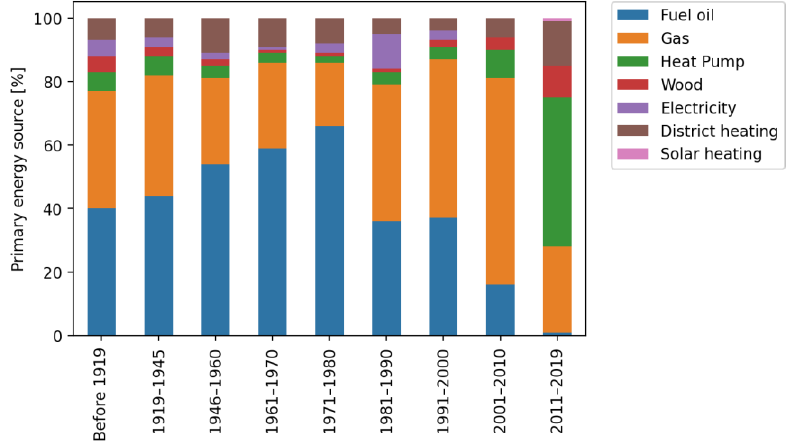
Figure 2. Primary energy source distribution by period of construction for multi-family houses.